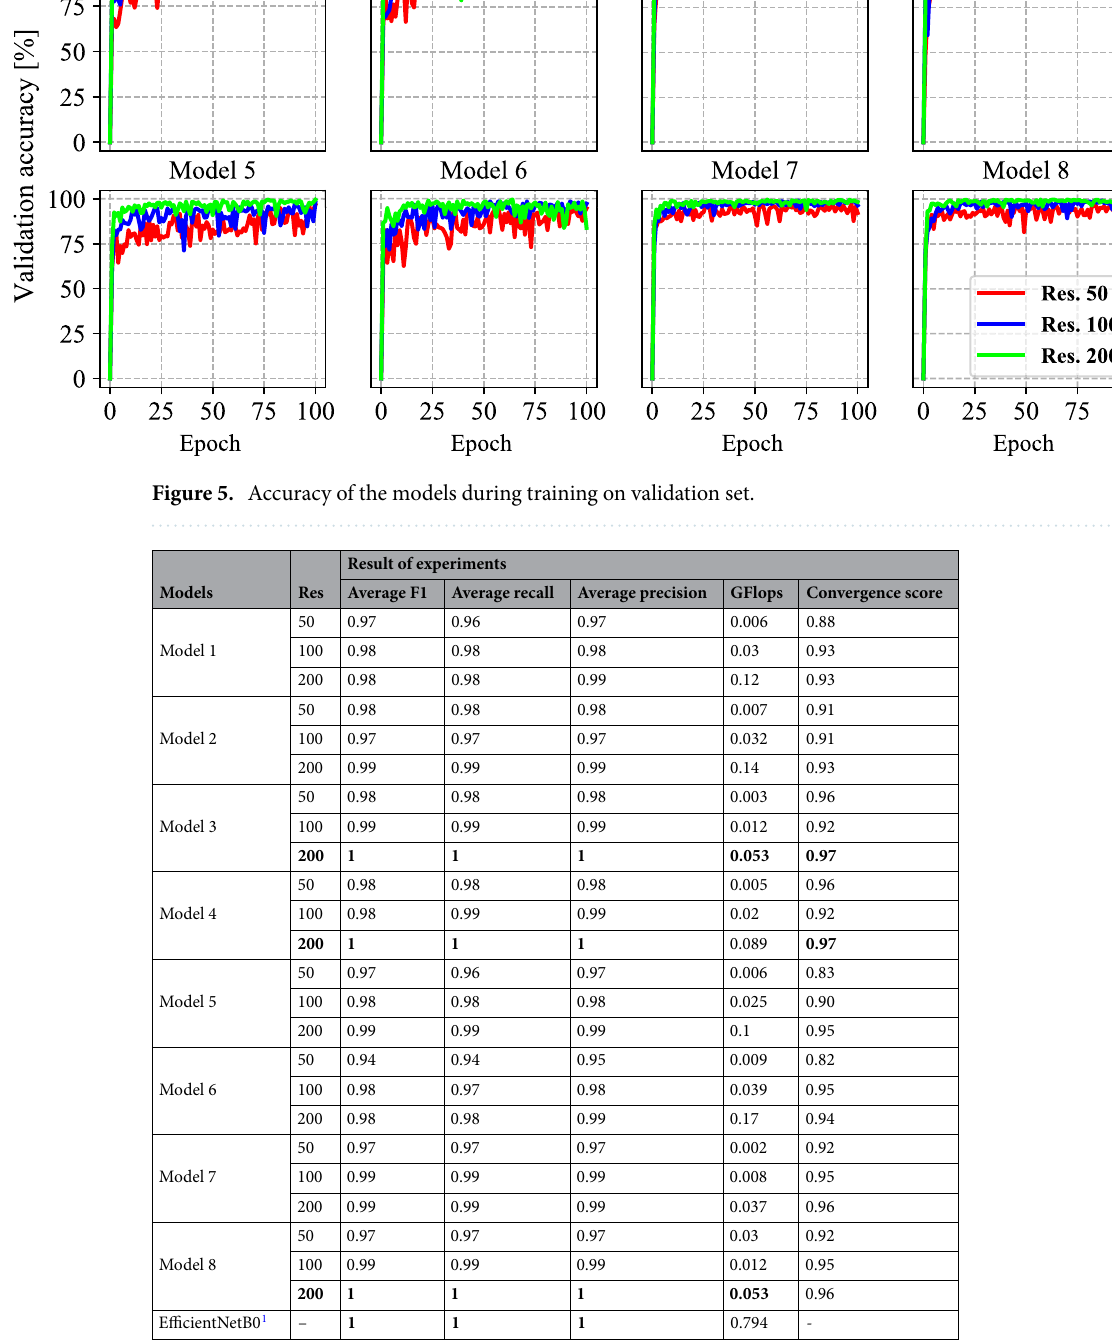
Table 1. The results of the Wheat Rust Classification Dataset experiment. Significant values are in